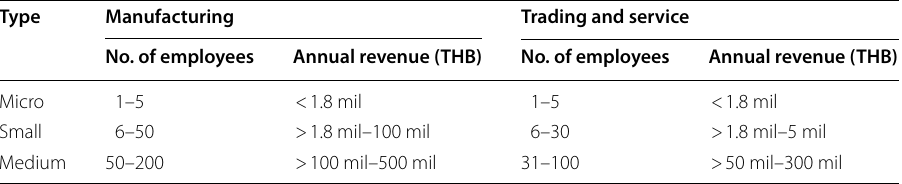
Source: The Office of SMEs Promotion